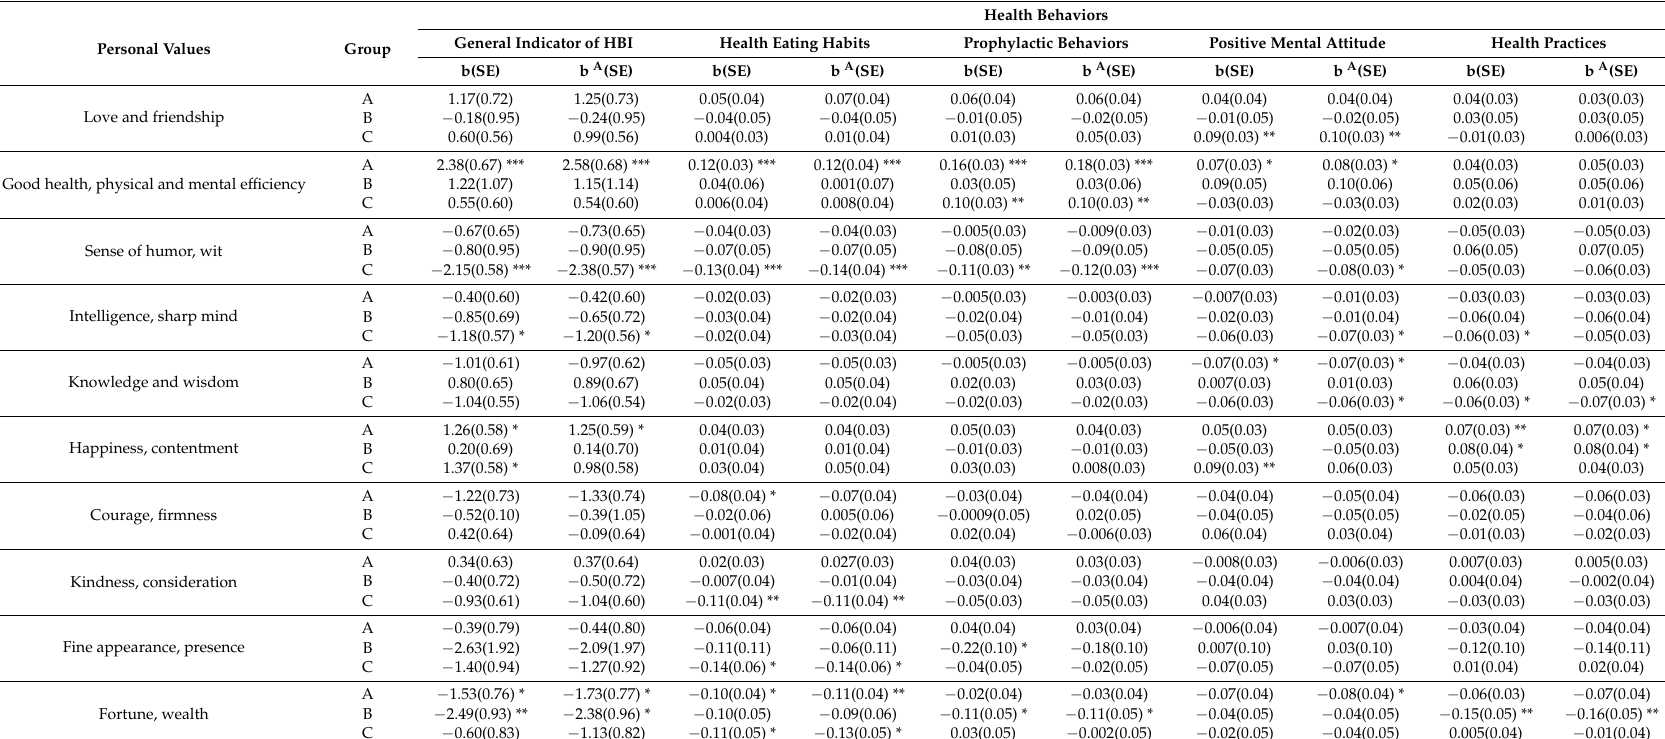
Table 6. Relationships between personal values and health behaviors of surveyed